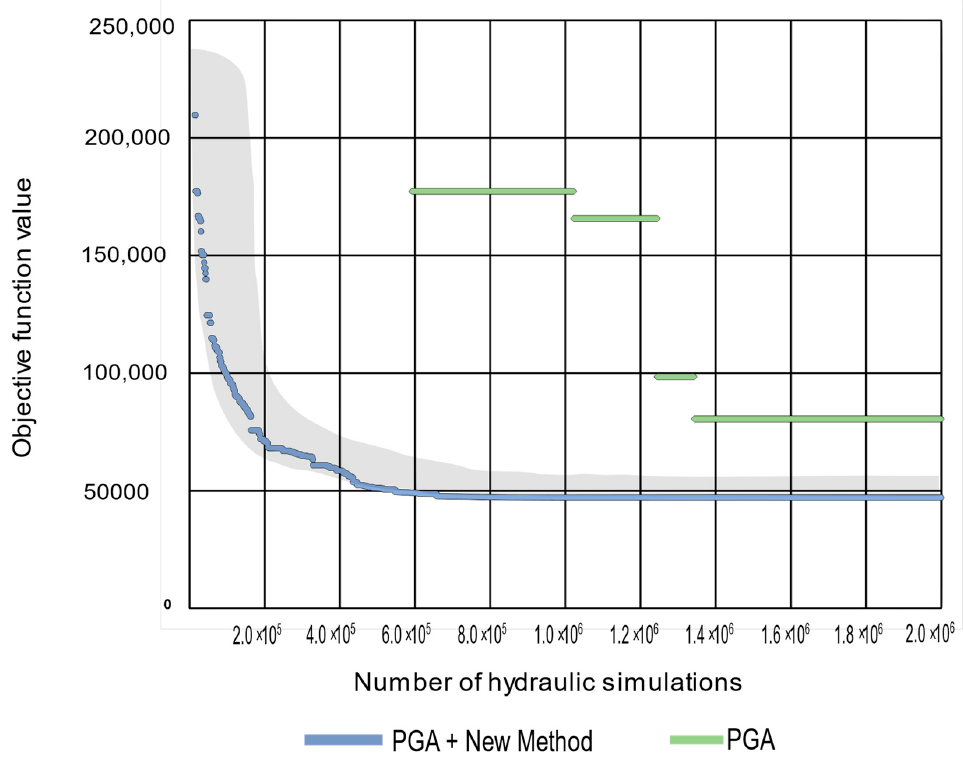
Figure 7. Comparison of the results with and without IMs. The blue dots represent the best solution obtained using the PGA with a search space limited by the IMs. The green dots show the best solution obtained using the PGA with the original method presented by [7], which utilized the complete search space. Addition- ally, the shaded area represents the complete distribution of all experiments simulated using IMs.